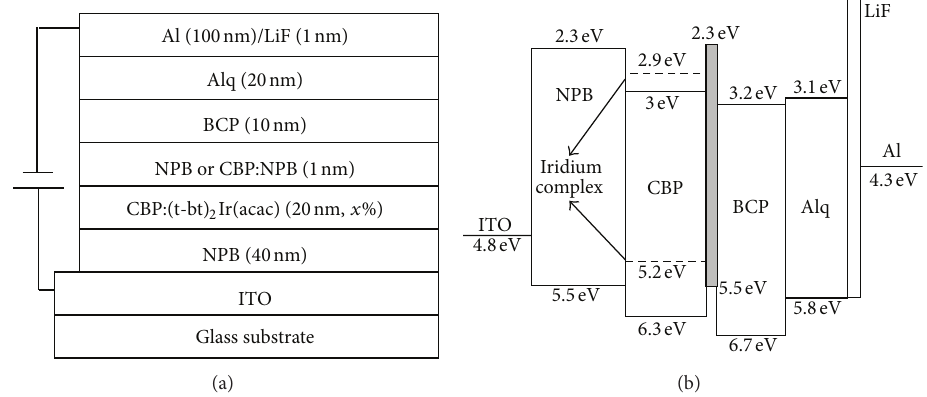
Figure 1: Device structure of organic devices and energy level diagram of relevant materials used in this study. The doping concentration of (t-bt) 2 Ir(acac) was 𝑥 wt% and ultrathin layer was 𝑦 layer (1nm), 𝑥 = 3 for device A and B, 𝑥 = 5 for device C and D, 𝑦 = CPB:NPB (1: 1) for device A and C, and 𝑦 = NPB for device B and